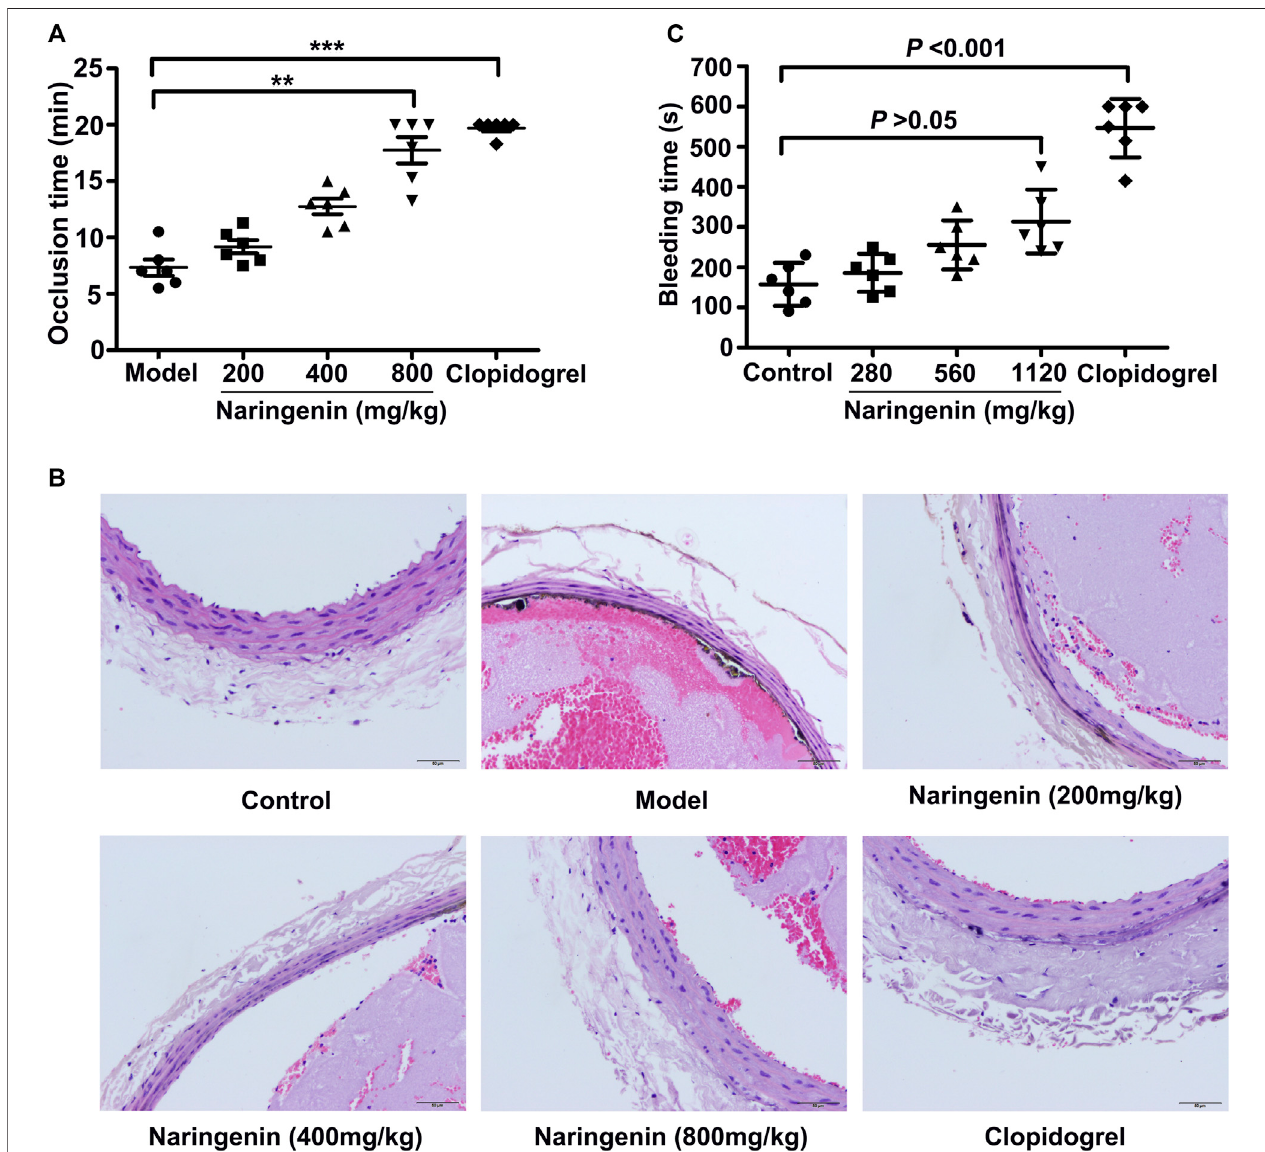
FIGURE9| Naringenin inhibits arterial thrombosisformationwithout bleeding risk. Arterial thrombosiswasinducedby10% FeCl 3 onthe common carotid artery of rats thatwereorallytreatedwithnaringenin(200,400, and800 mg/kg),clopidogrel (7.875 mg/kg) orvehicle (0.5% CMC-Na) for7 days.Timetoocclusion ofthecarotid arteryafterFeCl 3 injuryfor5 minwasmeasuredusingaTransonicModelTS420 fl owmeter (A) .RepresentativesectionsofH&E-stainedcarotidarteryfromratstreatedas labeled (B) .Magni fi cation:10 × 20.Naringenin(280,560,and1,120 mg/kg),clopidogrel(11.375 mg/kg) orvehicle(0.5%